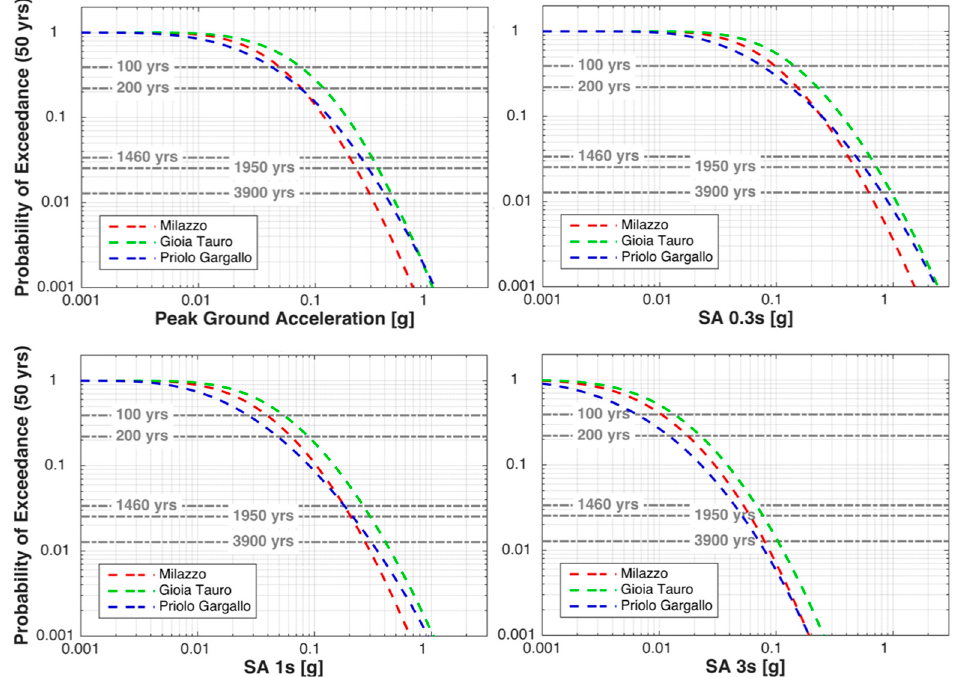
Figure 26. Probability of exceedance (50 years) for the three sites of interest, calculated for PGA and spectral acceleration [SA] at 0.3, 1, and 3 s, considering all the logic tree branches (see Figure 22).